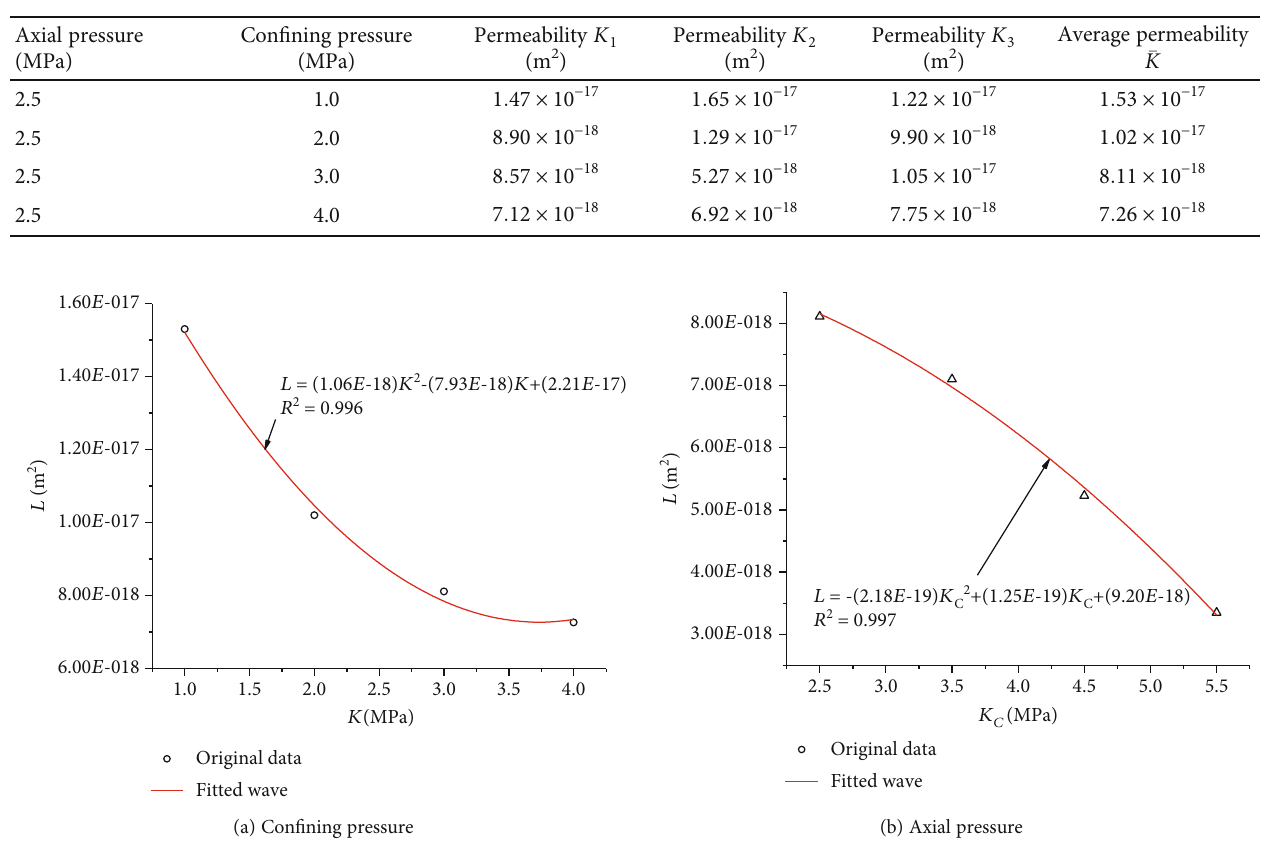
Table 2: Results of SBCB permeability tests under di ff erent con fi ning pressures.